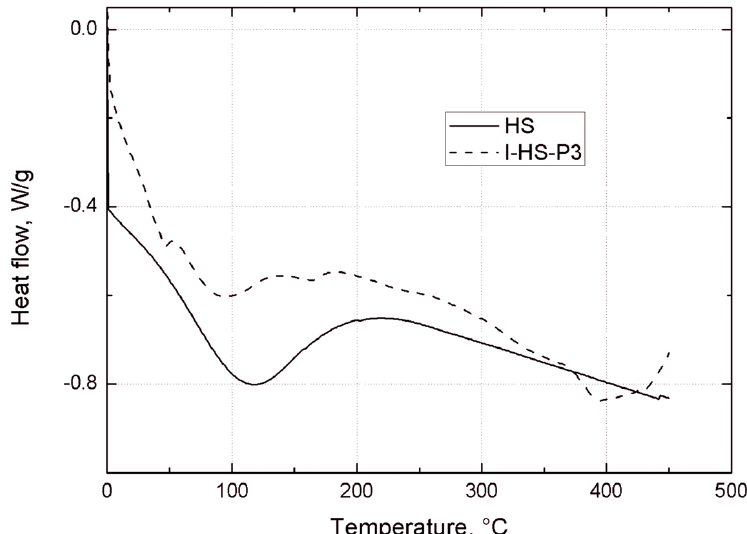
Figure 9. DSC curves for the studied bentonites: B, BP1, and